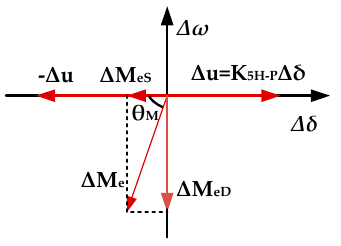
Figure 6. Torque phasor diagram during oscillation.